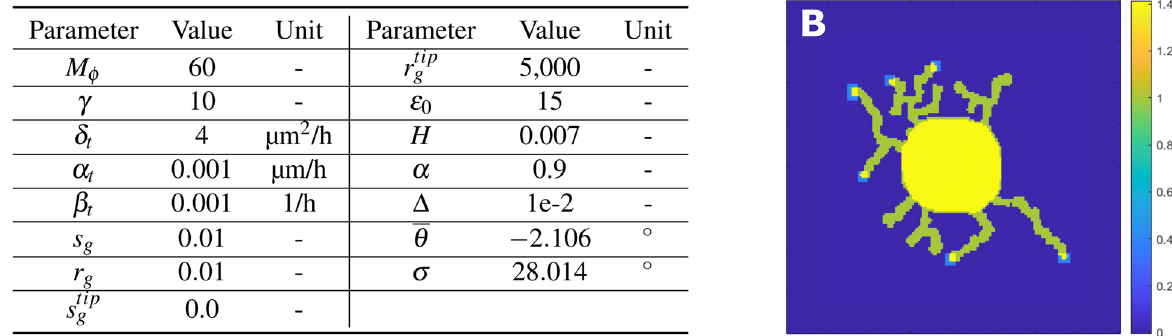
Figure 5. Parameter settings and simulation result showing how the phase field model is capturing neuron growth stages 1–4 using growth-cone-like activation of E . ( A ) Parameter settings for the phase field model. ( B ) φ overlaid with energy variable to highlighted energy activation